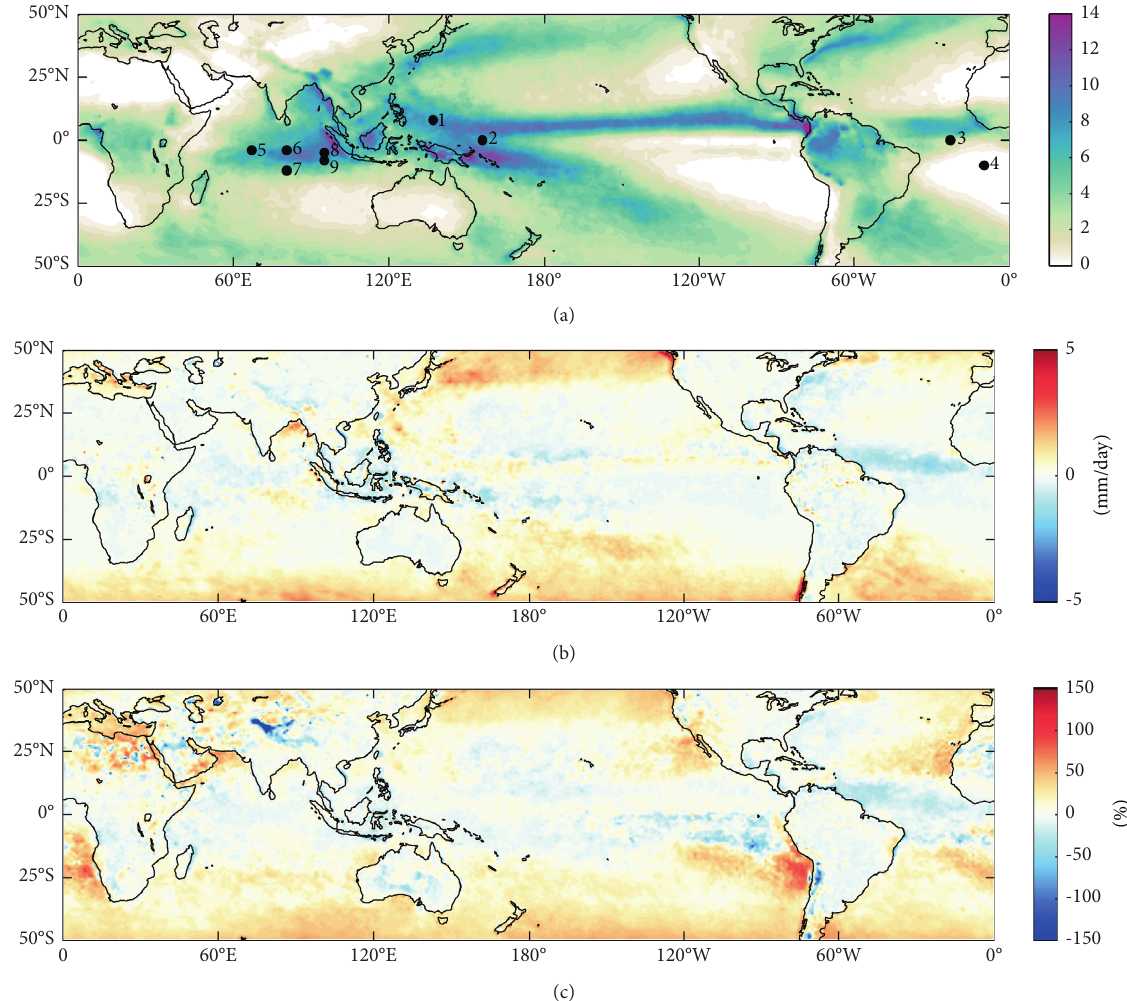
Figure 1: Climatological mean precipitations. (a) Five-year mean precipitation data from the IMERG V06B product. The positions of nine ocean buoys were marked; (b) mean differences (IMERG minus TMPA); (c) relative differences (IMERG minus TMPA, relative to the IMERG